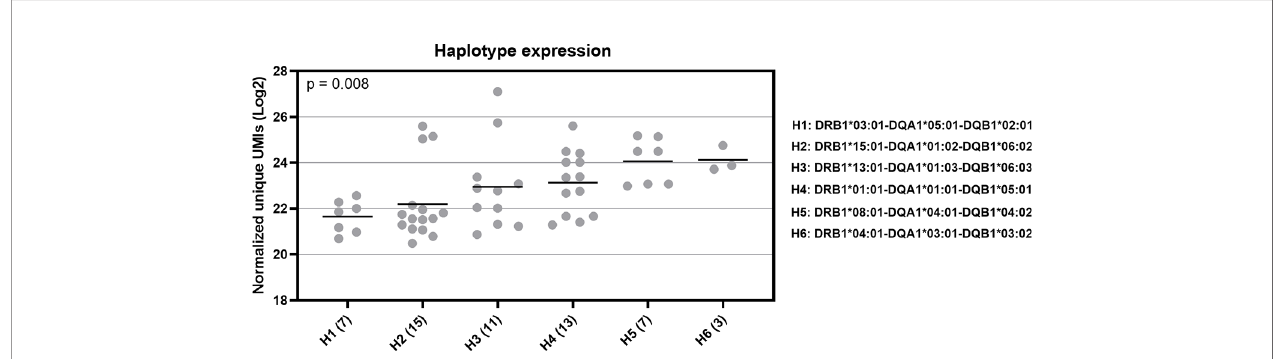
FIGURE 6 | RNA expression of six common HLA haplotypes in Finnish population. Y-axis indicates the normalized UMIs (Log2) of cDNA data and X-axis indicates the codes of the fi ve selected HLA haplotypes. The full haplotype names are marked on right side of the fi gure. The parenthesis following the haplotype codes indicate the number of the samples for each haplotype. Each dot refers to a UMI value and a solid bar indicates the median expression of the haplotype. Data were compared using a Kruskal-Wallis